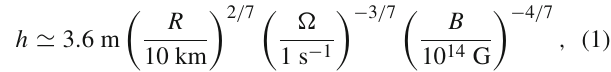
It is crucial, however, that all models of the rotating pulsar magnetospheres with the global force-free field configura- tions ( E (cid:5) = 0) are inconsistent with the Faraday law. (For a concise review, see Ref. [58].) This can be seen from a charge or current starvation in certain regions of the model magne- tospheres [37–40]. Therefore, the transient gap regions with E (cid:5) (cid:7)= 0 must develop in realistic